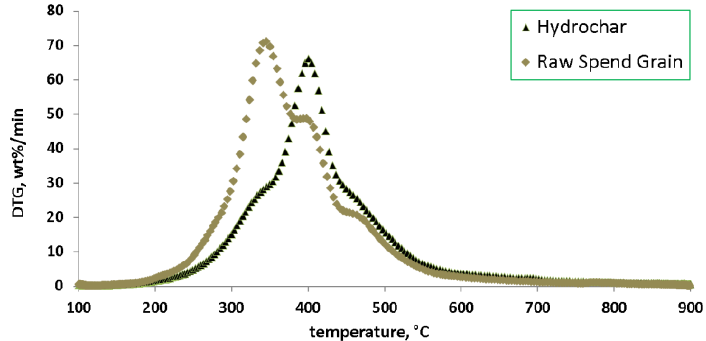
Table 4. Results of the qualitative gas chromatography – mass spectrometry (GC-MS) analysis — compounds detected in the HTC liquid, after de-watering using hydraulic press (IUPAC names from official online database of Royal Society of Chemistry [53]). Compound